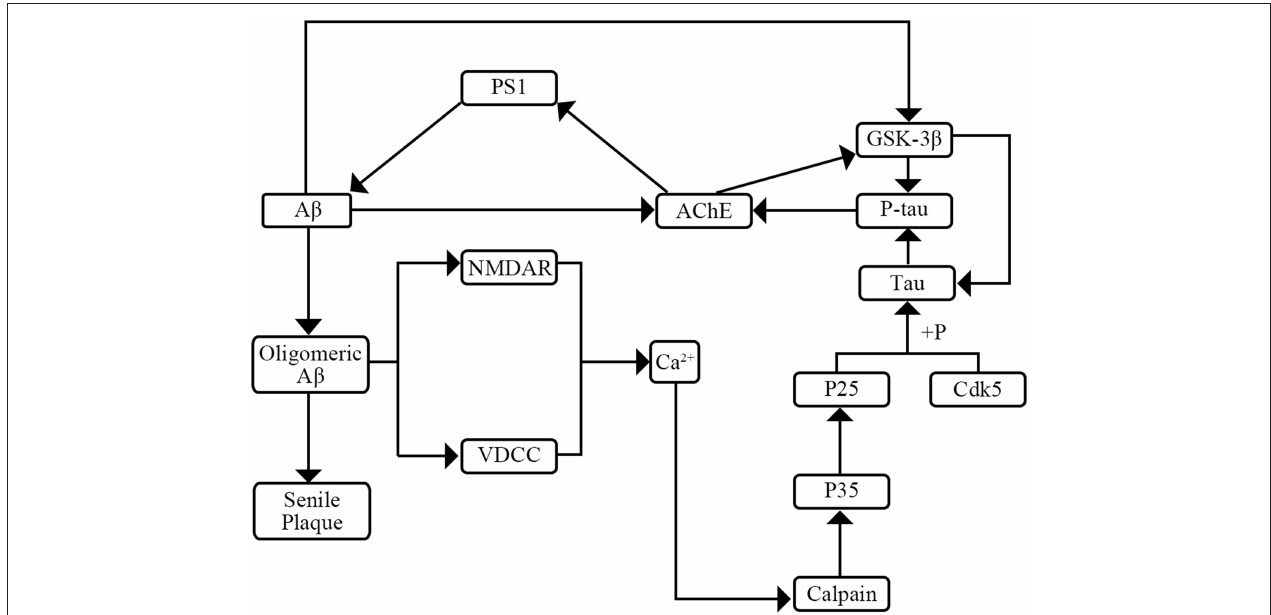
FIGURE 1 | The interaction of A β , tau, and